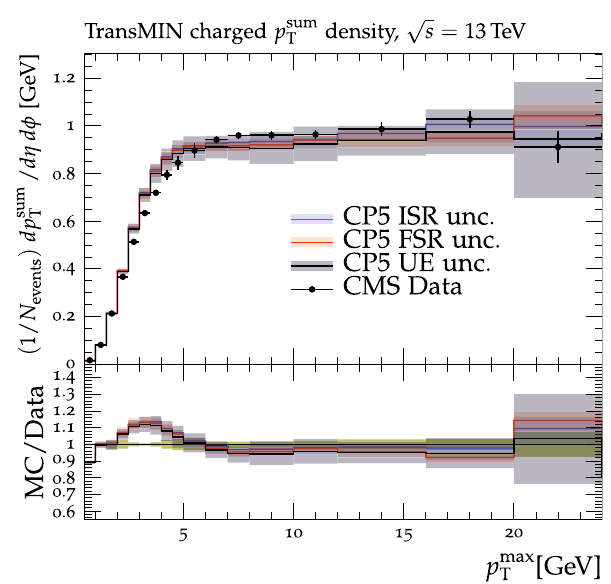
Fig. 25 The variations allowed by the CP5 tune when α ISR ( m ) (red band) are left free in the fit for charged- band) and α FSR Z S particle (left) and charged p sum (right) density in the transMIN region √ T s = 13TeV. Vertical lines drawn on the data points refer to the at